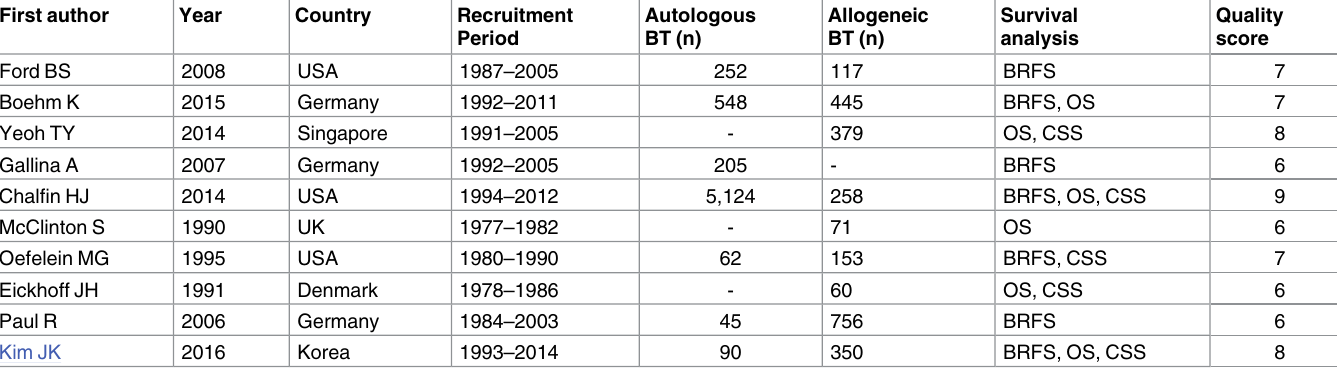
Table 1. Characteristics of the eligible studies in the